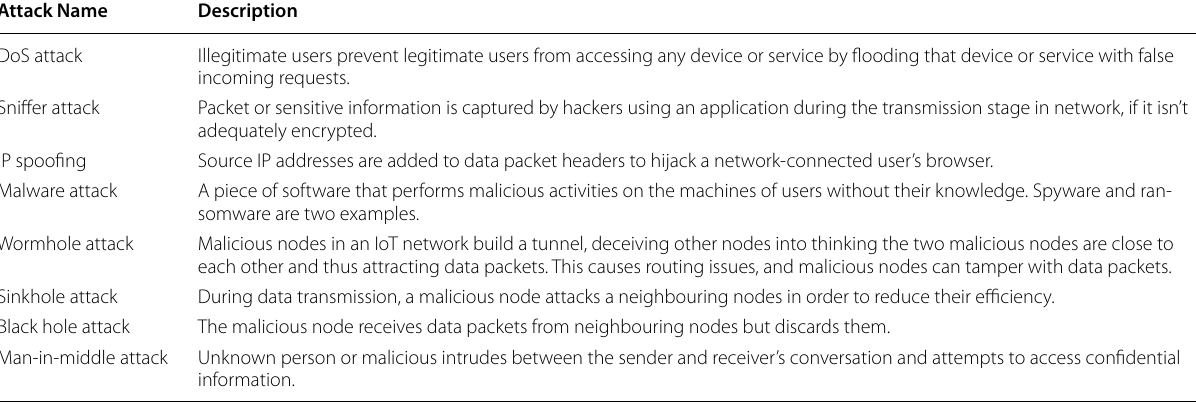
Table 3 Summary of different attacks in IoT system